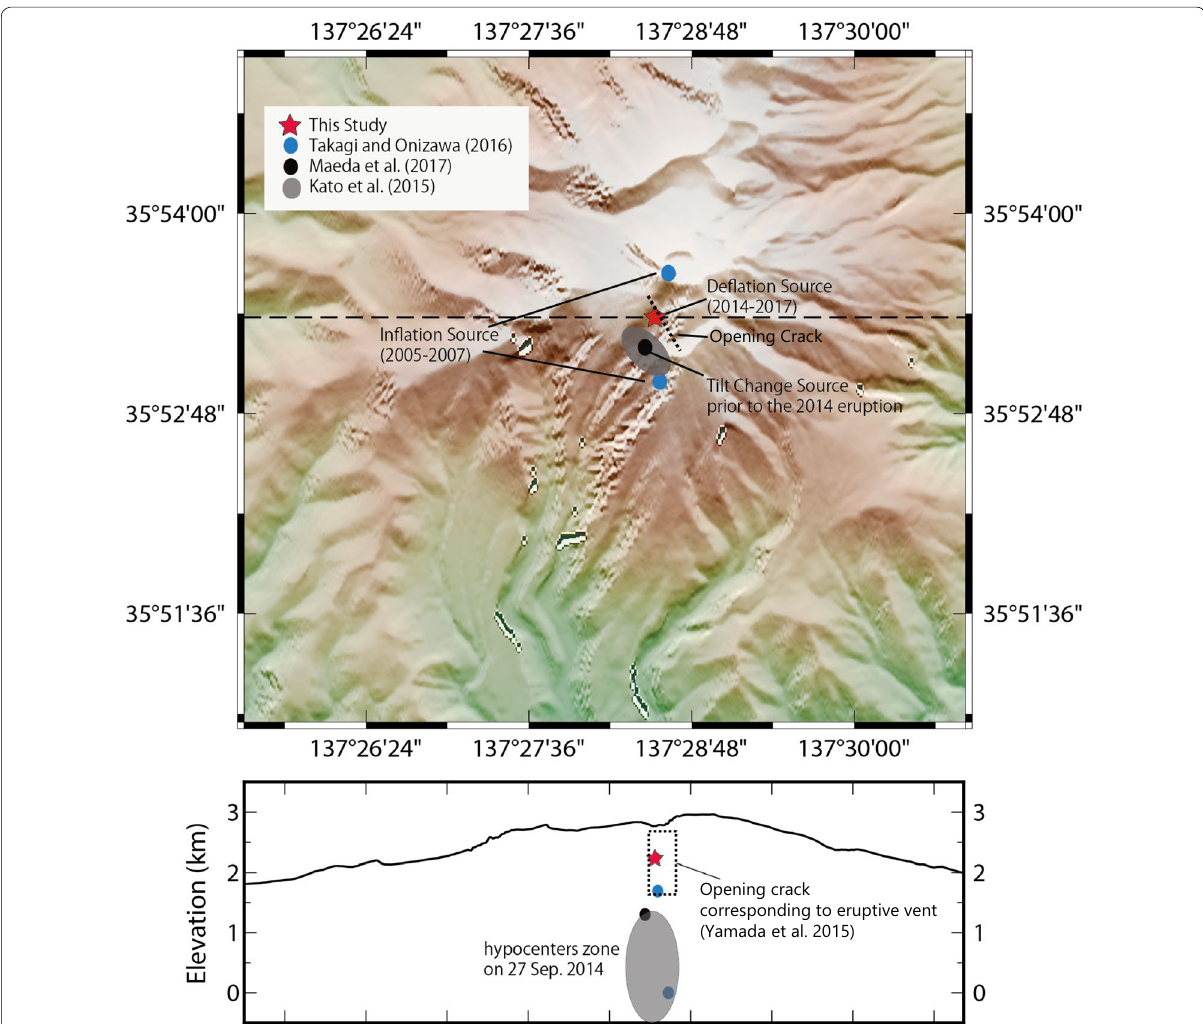
Fig. 6 Source locations. Red star, blue circles, and black circle correspond to deflation source estimated by this study, inflation sources for the 2007 eruption (Takagi and Onizawa 2016), and tilt change source 7 min prior to the 2014 eruption (Maeda et al. 2017), respectively. Gray zone is the hypocenters zone in the 2014 eruption (Kato et al. 2015). Dotted line (in upper figure) and dotted rectangle are opening crack in the 2014 eruption (Yamada et al.